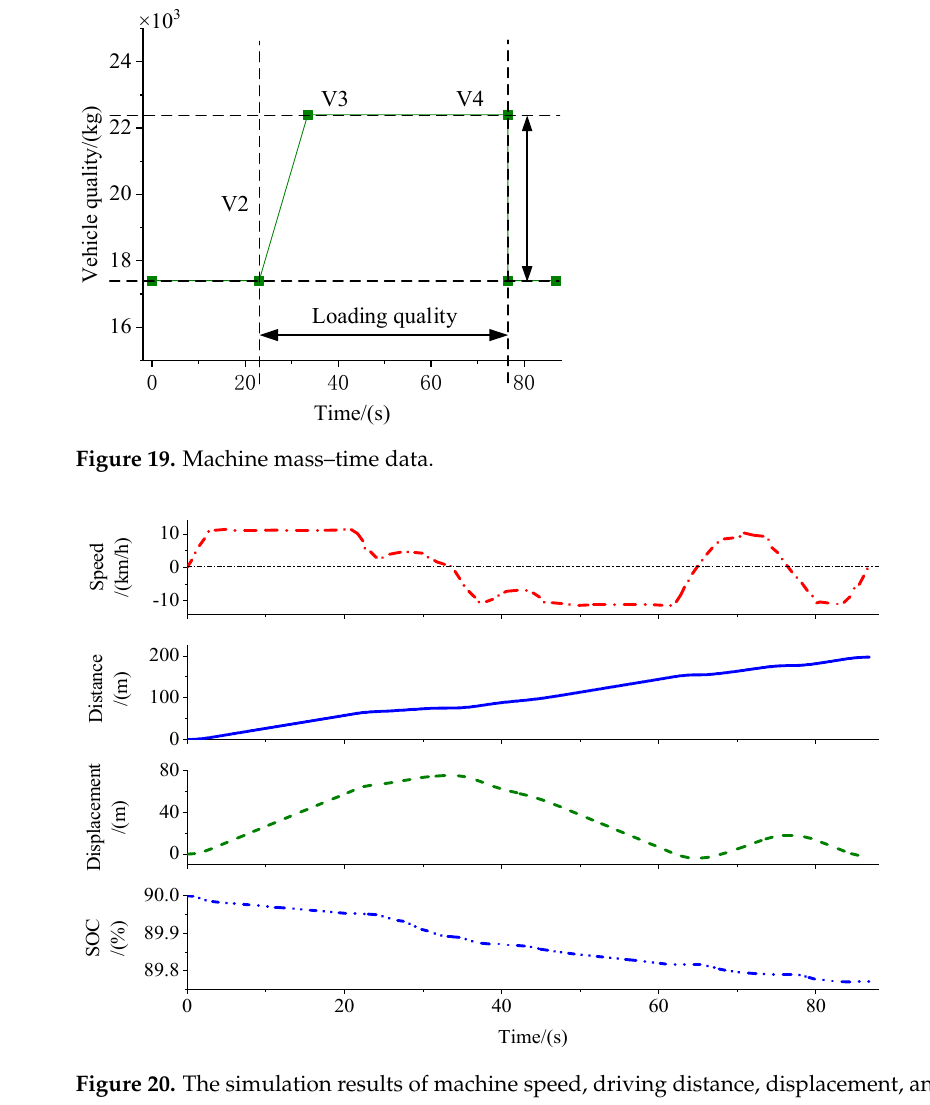
Figure 20. The simulation results of machine speed, driving distance, displacement, and SOC.